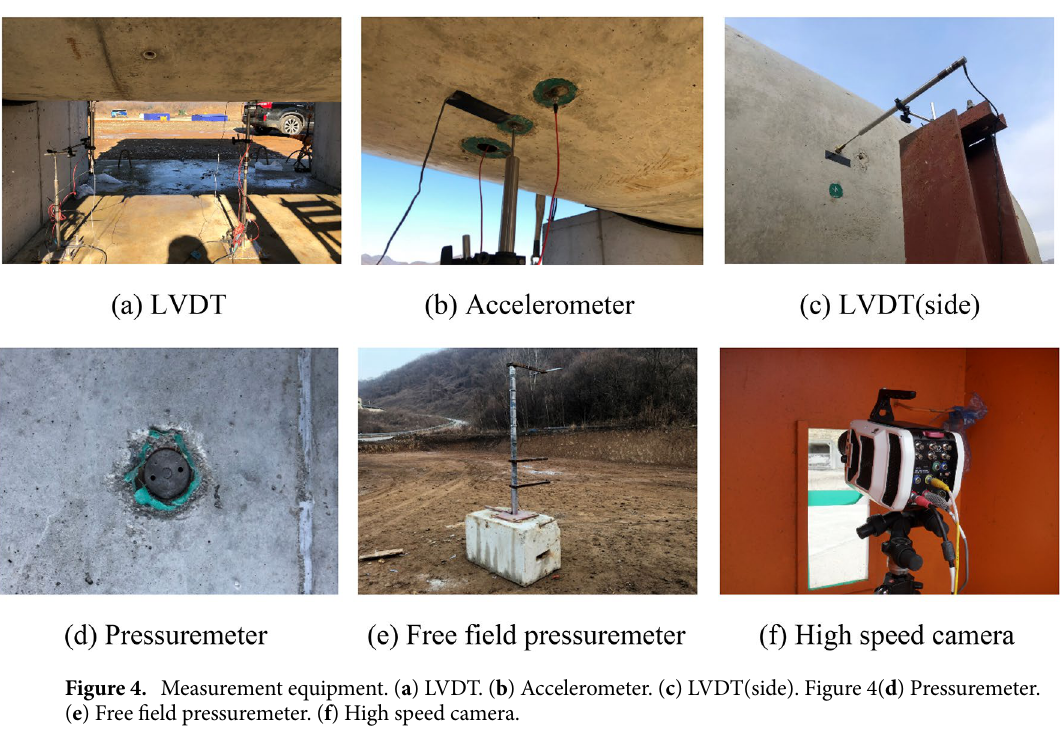
Figure 4. Measurement equipment. ( a ) LVDT. ( b ) Accelerometer. ( c ) LVDT(side). Figure 4( d ) Pressuremeter. ( e ) Free field pressuremeter. ( f ) High speed camera.